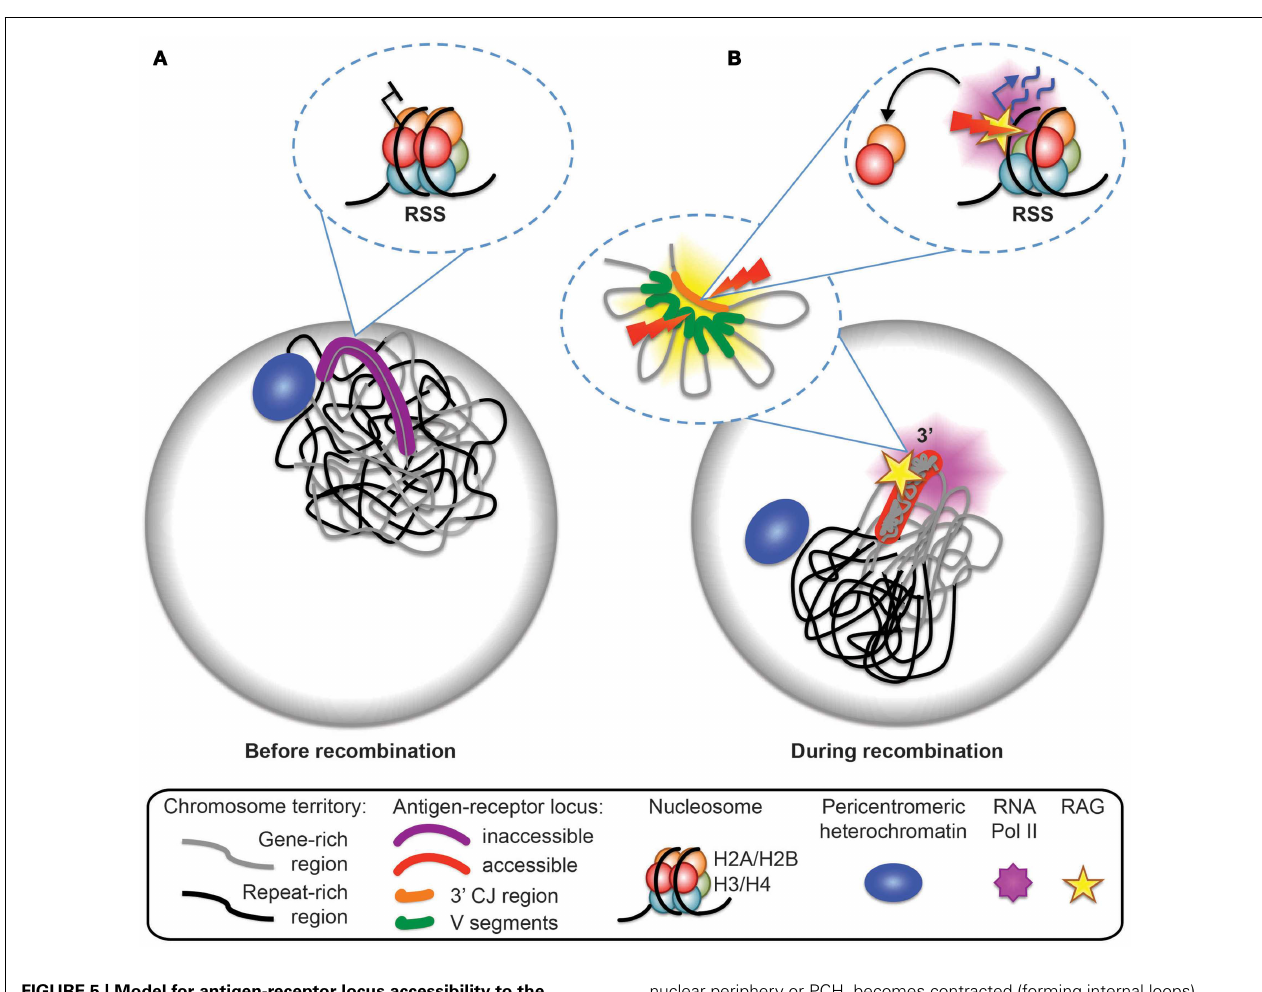
FIGURE 5 | Model for antigen-receptor locus accessibility to the RAG complex at the time of recombination . (A) In non-recombining cells, the antigen-receptor locus is inactive, decontracted, and stays within its chromosome territory. It is located at the nuclear periphery or close to pericentromeric heterochromatin (PCH). (B) At the time of recombination, the antigen-receptor locus leaves the vicinity of the